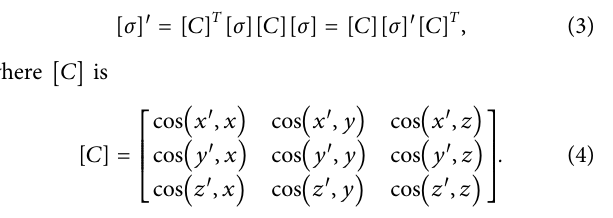
Matrix (cid:5) C (cid:6) is de fi ned as the rotation tensor between the local